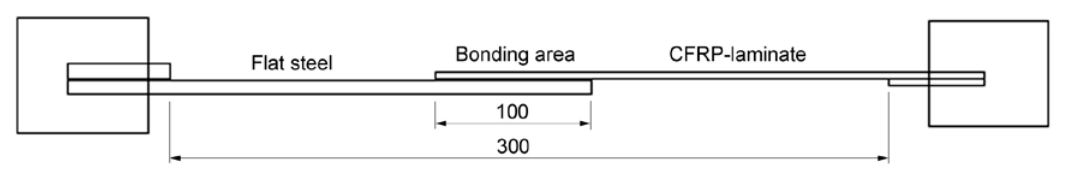
Figure 3. Lap-shear-specimen for shear, fatigue and creep tests